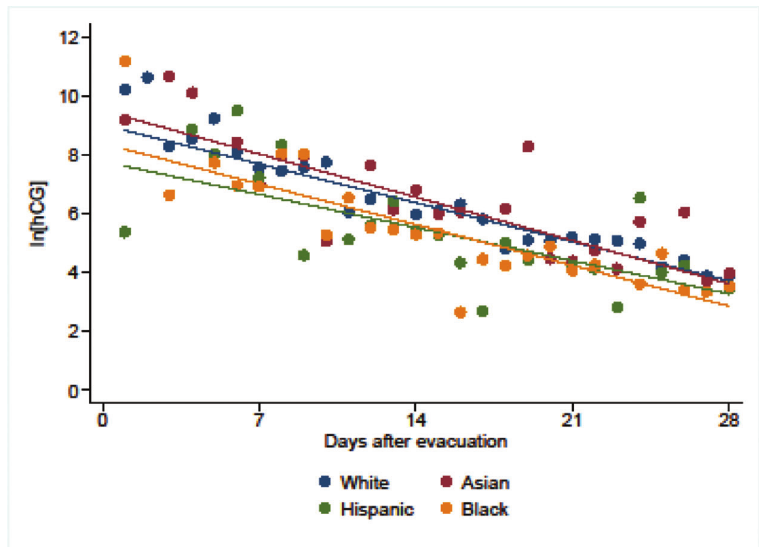
Figure S2 - Human gonadotropin (hCG) regression curves by race/ethnicity for all molar pregnancies. Each point represents the mean hCG level. No significant differences were noted in the rate of hCG regression by race for all ( p =0.16), complete ( p =0.51), or partial ( p =0.41) molar pregnancies.